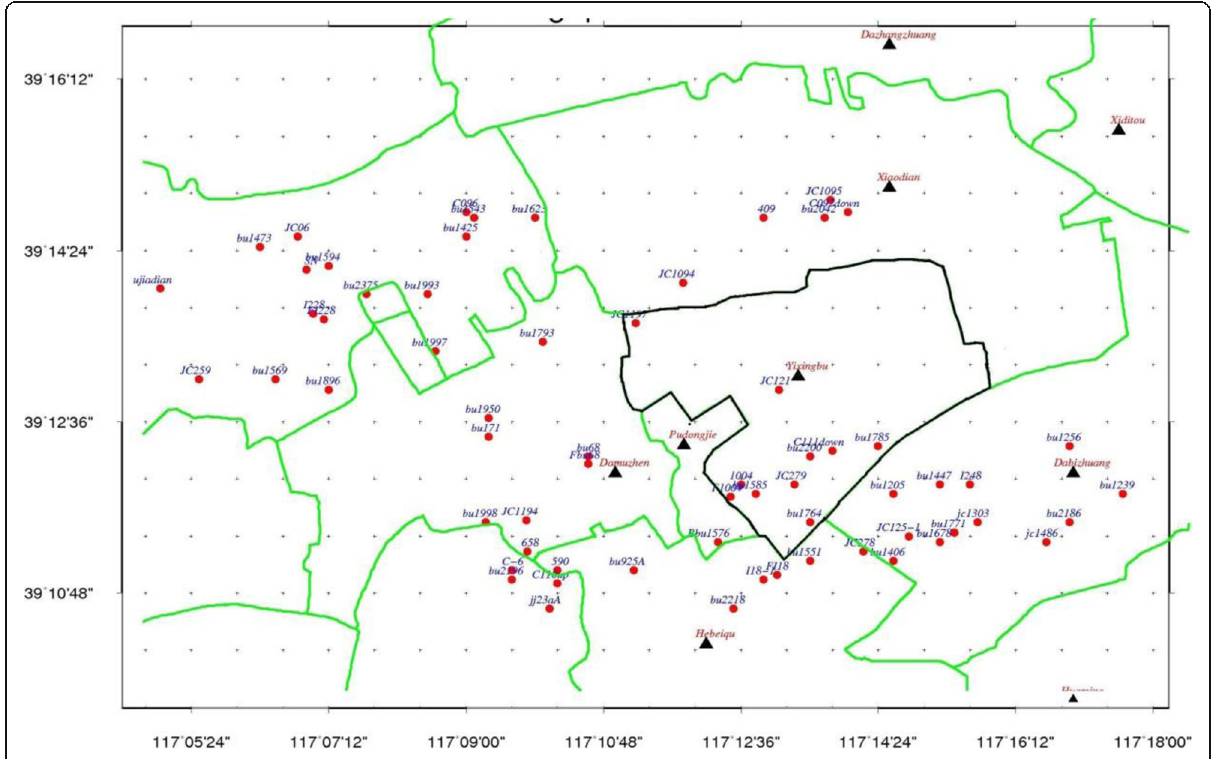
Fig. 6 Level points of the study area